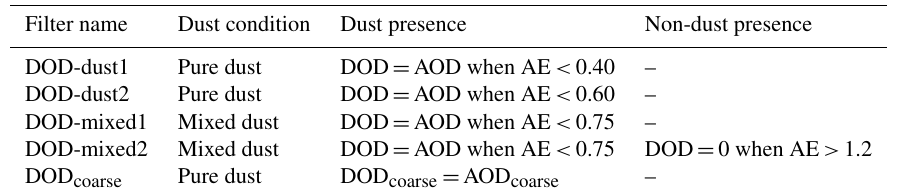
Table 6. Dust filters applied to the AERONET retrievals.